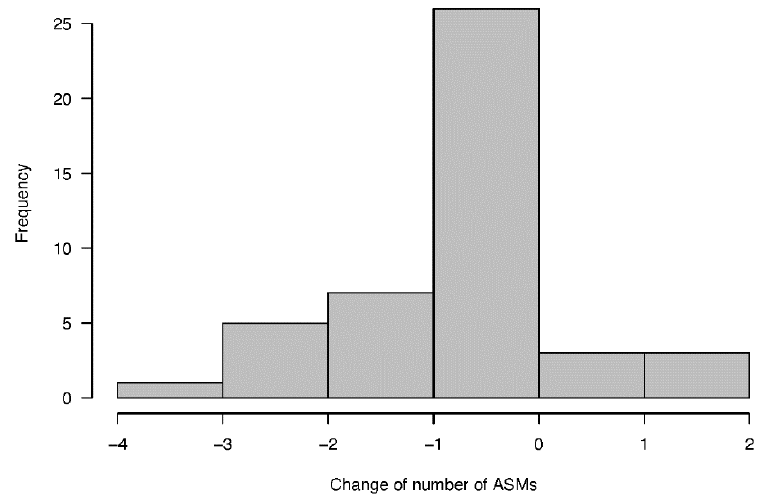
Figure 4. Frequency histogram of change of the number of ASMs.